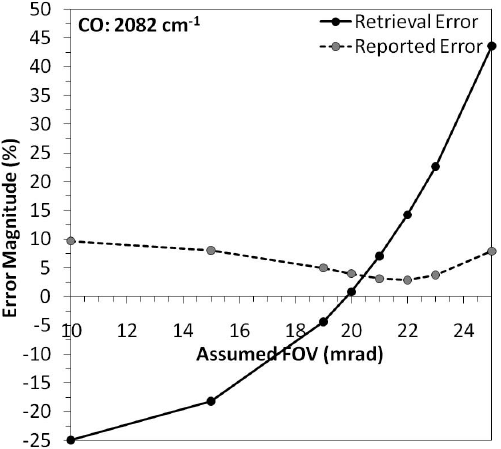
Fig. 5. Sensitivity of the reported error (based on the fit residuals) and retrieval error (based on the difference between retrieved path- length trace gas amount and actual pathlength trace gas amount) to assumed instrument FOV. The example is shown for CO trace gas retrievals based on the CO absorption line centred at 2082cm − 1 (Fig. 6). Measurements were made at a low pressure of 400.5hPa with a true CO mixing ratio of 1217.05ppm. Reported error is min- imised at an assumed FOV of 22mrad, though is relatively insen- sitve to the FOV variations studied here. Retrieval error is, however significantly more sensitive, and assumed 20mrad FOV yields the smallest actual retrieval error.